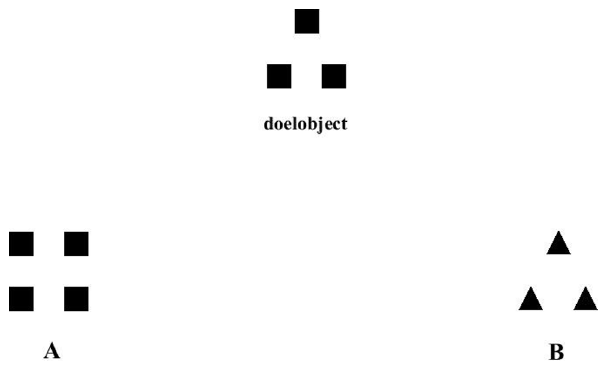
Figure 1. Example of an item used in the perceptual focus task. The target object (in Dutch ‘doelobject’) is a triangle (pattern) consisting of three squares (individual properties). The alternative figure A represents the individual perspective (same individual objects). Alternative figure B represents the relational perspective (same pattern).